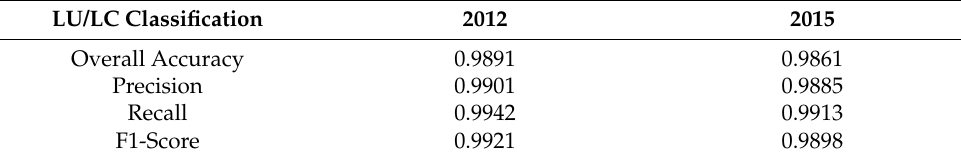
Table 7. LU/LC accuracy assessment for the proposed Vision Transformer